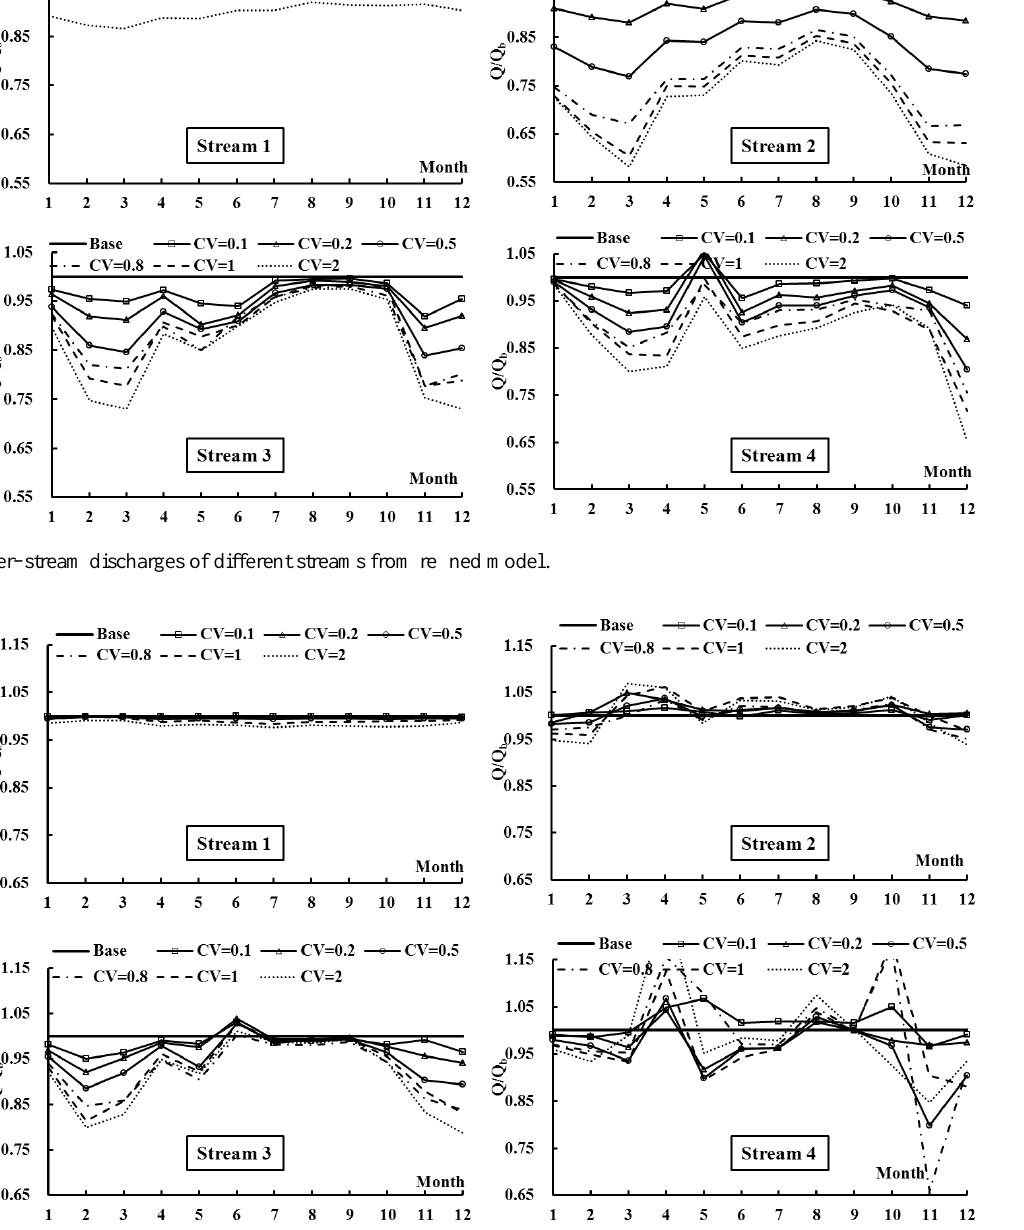
the corresponding base model in every sub-stream during at least some months (Fig.